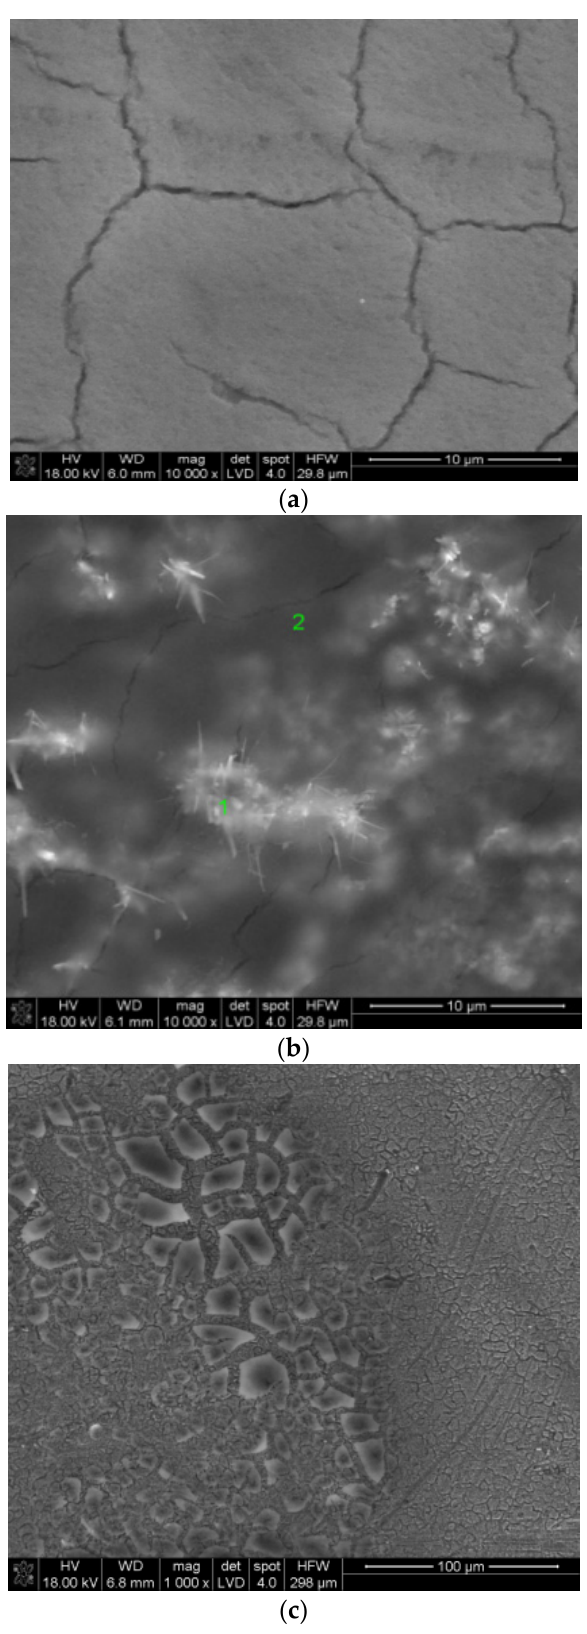
Figure 9. SEM images of: ( a ) the thin film deposited from Aerosil TM solution on steel; ( b ) the thin film deposited from Aerosil TM solution on titanium; ( c ) the thin film deposited from TEOS/DDS containing sol on steel substrate.